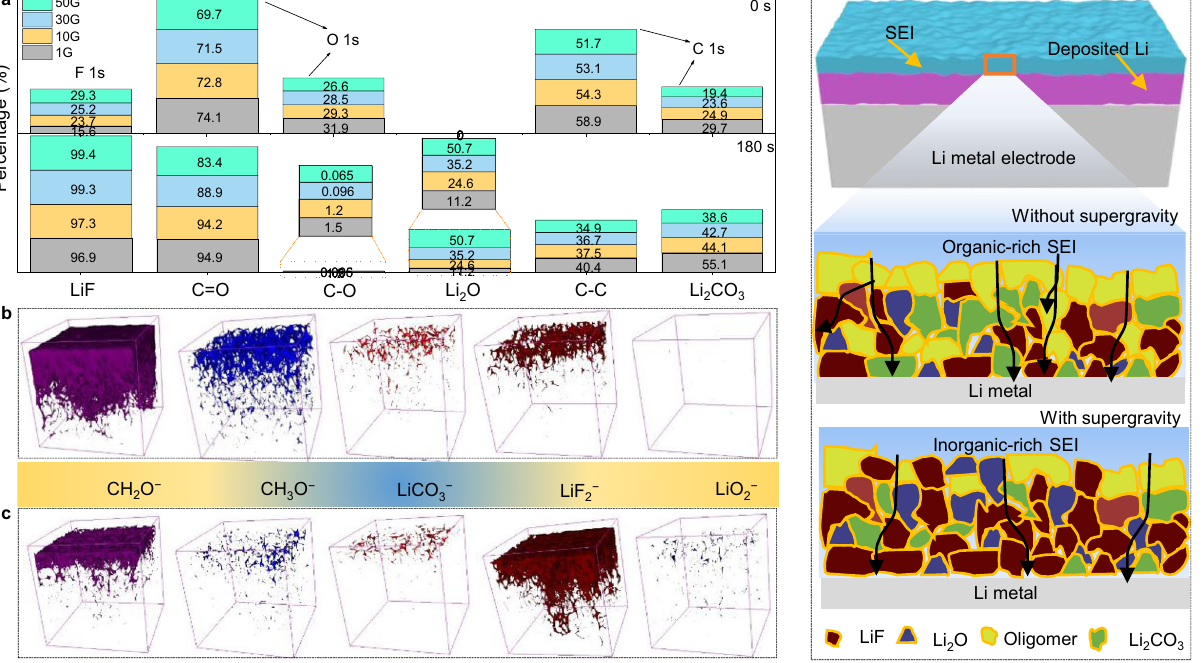
Fig. 6 Characterization of the SEI composition under different gravity conditions. a Comparison of the percentage of each key component in the SEI to the entire spectrum under different gravity coef fi cients. 3D views of the element distribution in the TOF-SIMS sputtered volumes of cycled Li electrode with gravity coef fi cient of b 1G and c 50G. d Schematic illustration of SEI structure on the surface of Li electrode under normal gravity and